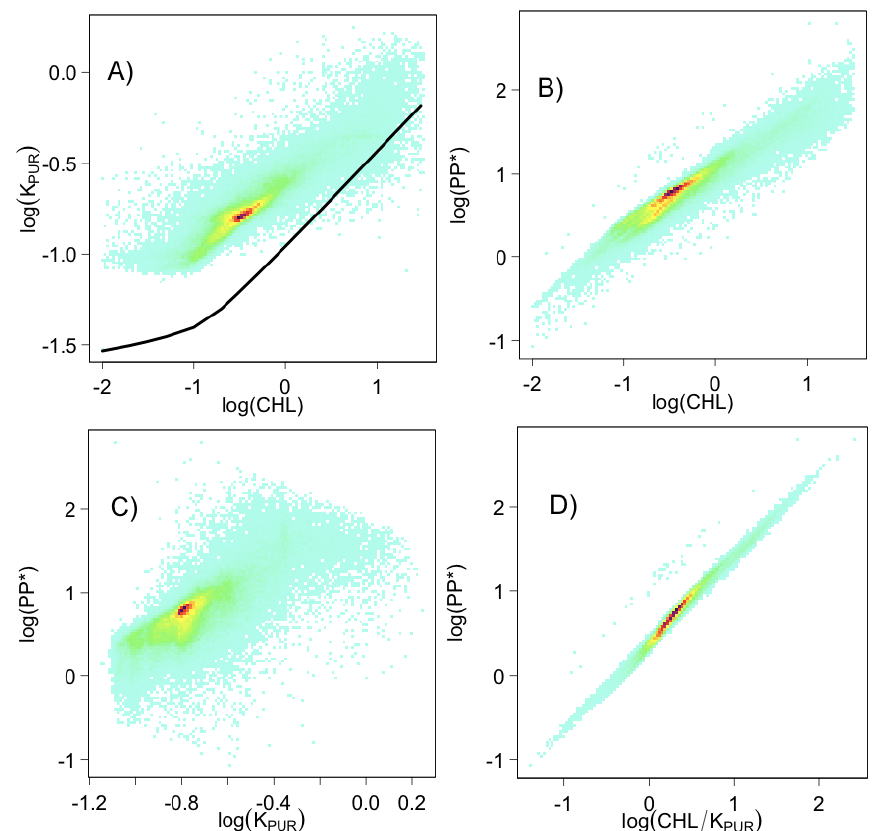
Fig. 4. Examples of relationship between (A) CHL and K PUR , (B) CHL and PP normalized by surface PAR (PP*), (C) K PUR and PP*, and (D) CHL/K PUR and PP* for the month of July 2007. The black line on panel (A) is K PUR predicted from CHL using the empirical model of Morel and Maritorena (2001) for K d and Matsuoka et al. (2011) for a ph